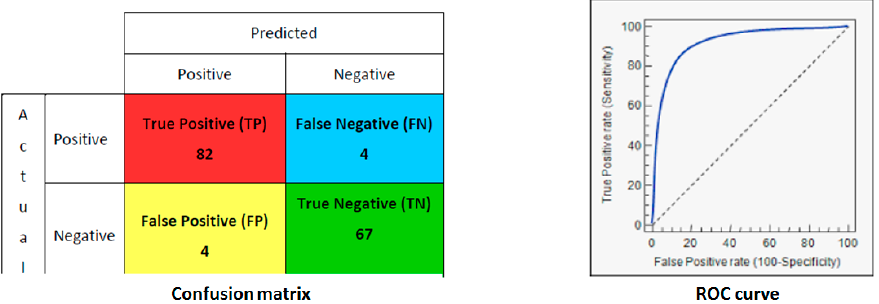
Figure 2. Confusion matrix (on the left) and ROC curve (on the right) made with 157 samples with different five-sensor combinations of 19 materials. True Positive Rate (TPR) = sensitivity = 95%, True Negative Rate (TNR) = specificity =